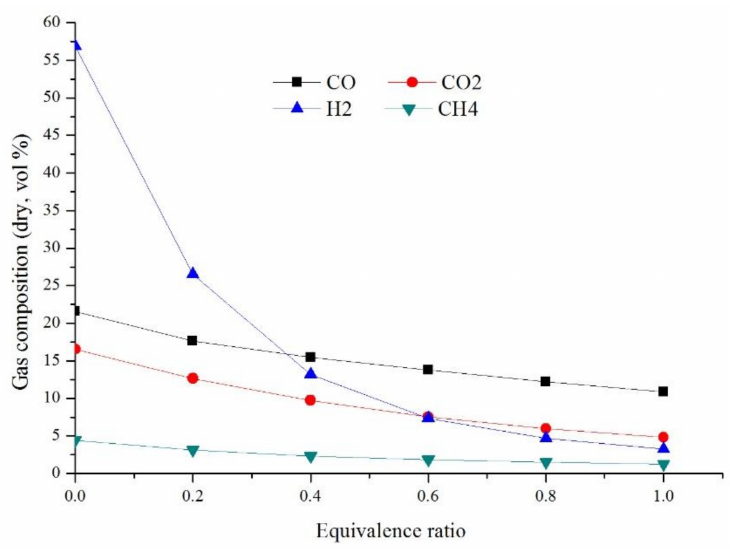
Figure 11. E ff ect of ER on syngas composition (Simulation, S / C = 2, T = 700 ◦